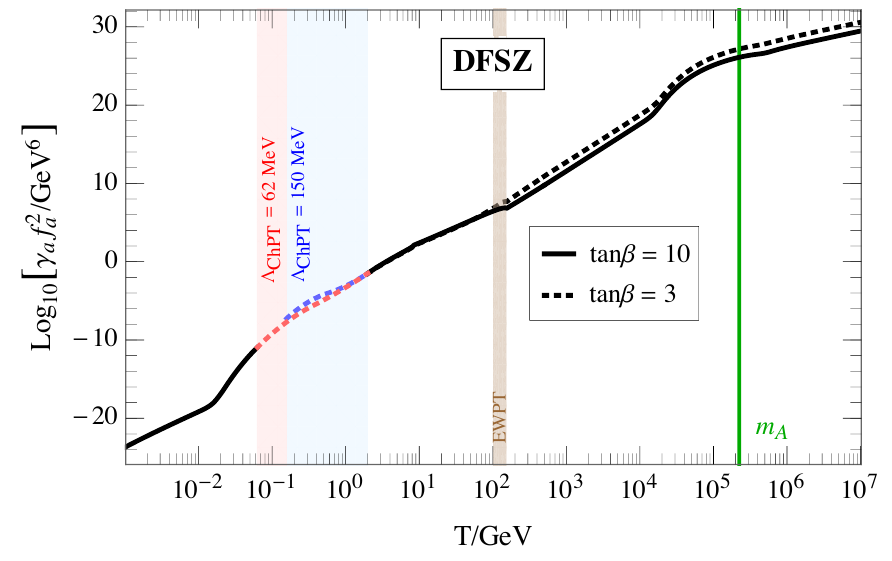
√ 5 × 10 5 GeV , tan β = (10 , 3) (solid,